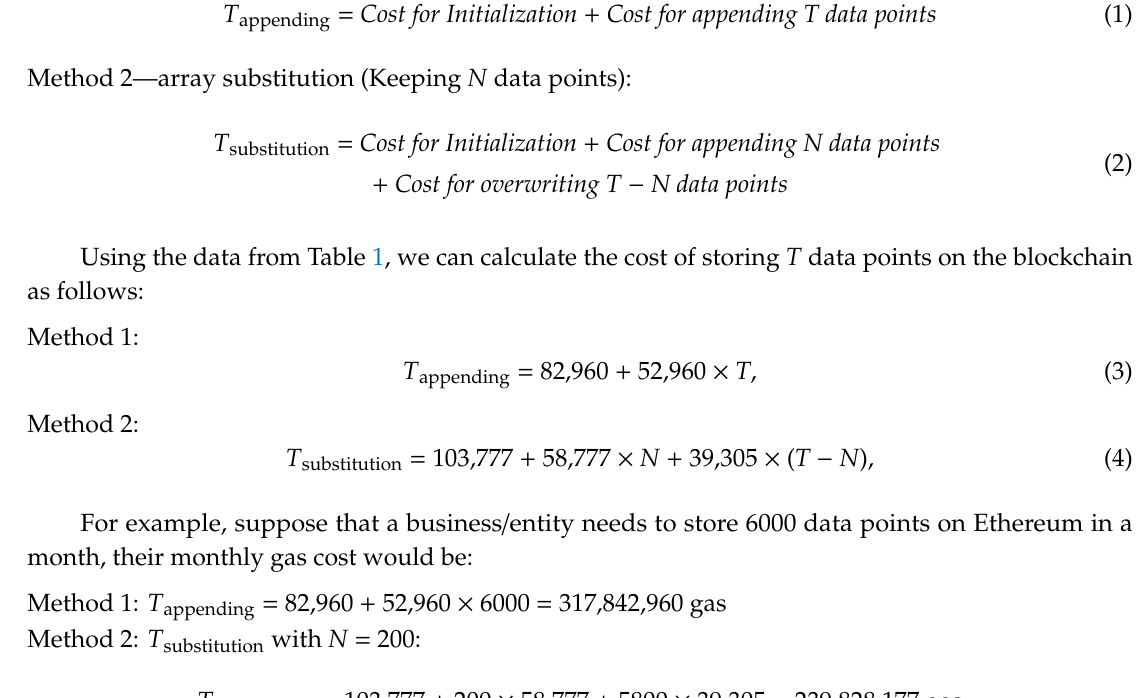
Table 1. Average gas consumption of storage options.